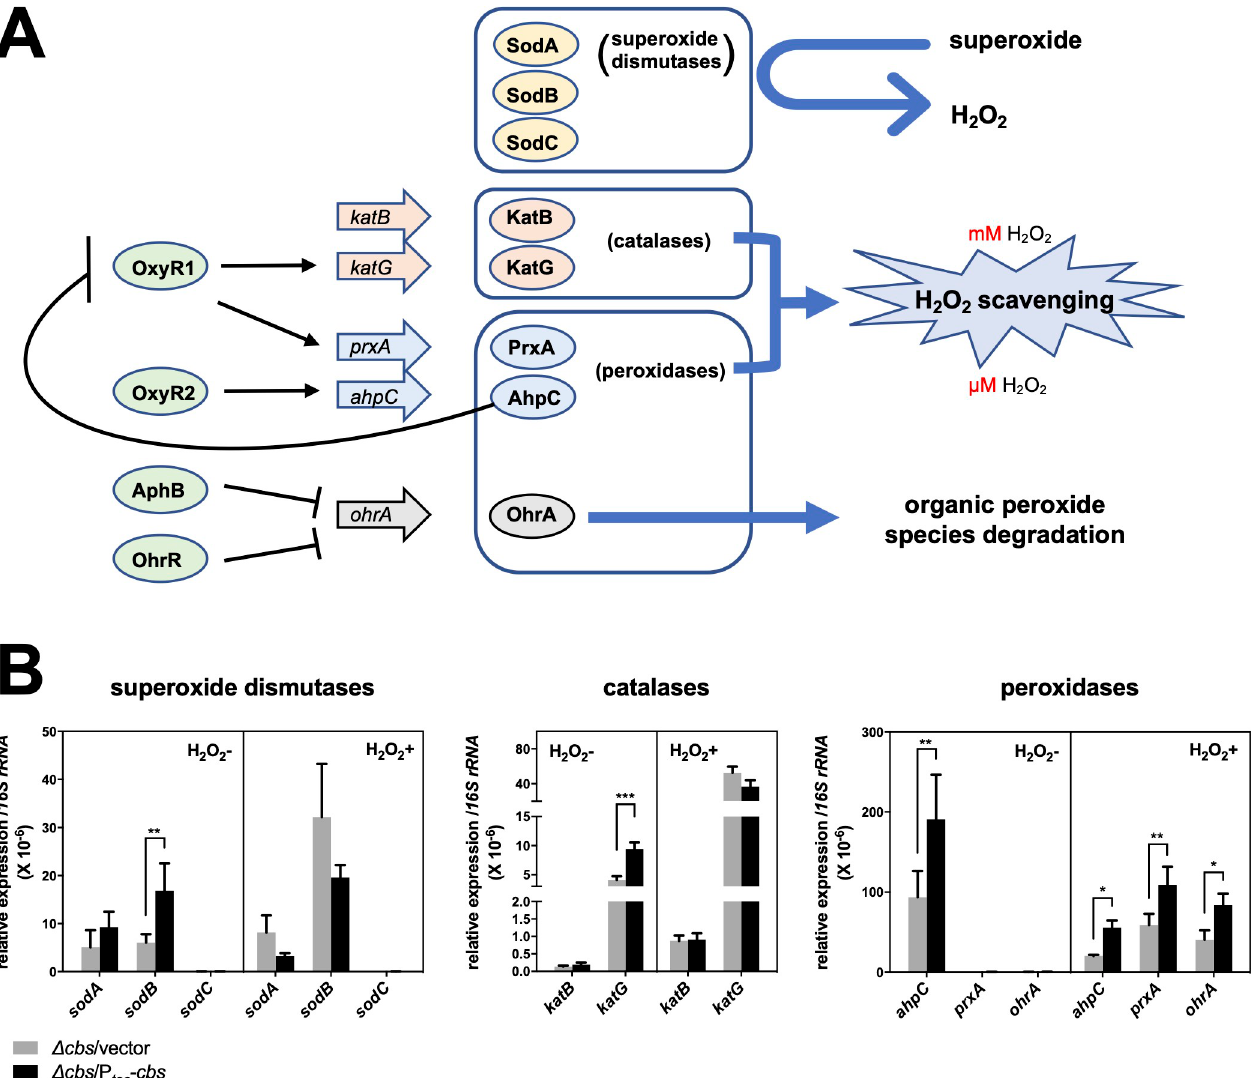
Fig 3. CBS-derived H 2 S stimulates the expression of enzymatic ROS scavengers. (A). Illustration for enzymatic ROS scavengers in V . cholerae . Up to date, there are three SODs, VC2694 (SodA), VC2045 (SodB), and VC1583 (SodC), two catalases, VC1585 (KatB) and VC1560 (KatG), and three peroxidases, VC0731 (AhpC), VC2637 (PrxA), and VCA1006 (OhrA), reported for V . cholerae [6–9].Expression of katG and prxA are positively regulated by transcription factor VC2636 (OxyR1), while ahpC expression is activated by VC0732 (OxyR2), and in turn inhibits OxyR1 expression [9]. SODs detoxify superoxide and generate H 2 O 2 . OhrA specifically degrades organic peroxide species. Peroxidases are the primary scavengers confronting low micromolar ( μ M) level of H 2 O 2 , while catalase activity predominates at millimolar (mM) levels of H 2 O 2 [4]. (B). cbs expression and enzymatic antioxidants expression. The relative expression of SODs, catalases, and peroxidases in exponentially grown cbs deletion mutant ( Δ cbs /vector), and cbs overexpression strain ( Δ cbs/ P tac -cbs ), with or without H 2 O 2 treatment (1 mM, 10 min), was examined by real-time qPCR. cbs expression was induced by 200 μ M of IPTG. Values expressed are means ± S.D. from three experiments. Significance was determined by t -test; p -value: � , < 0.05, �� , < 0.01, ��� , <